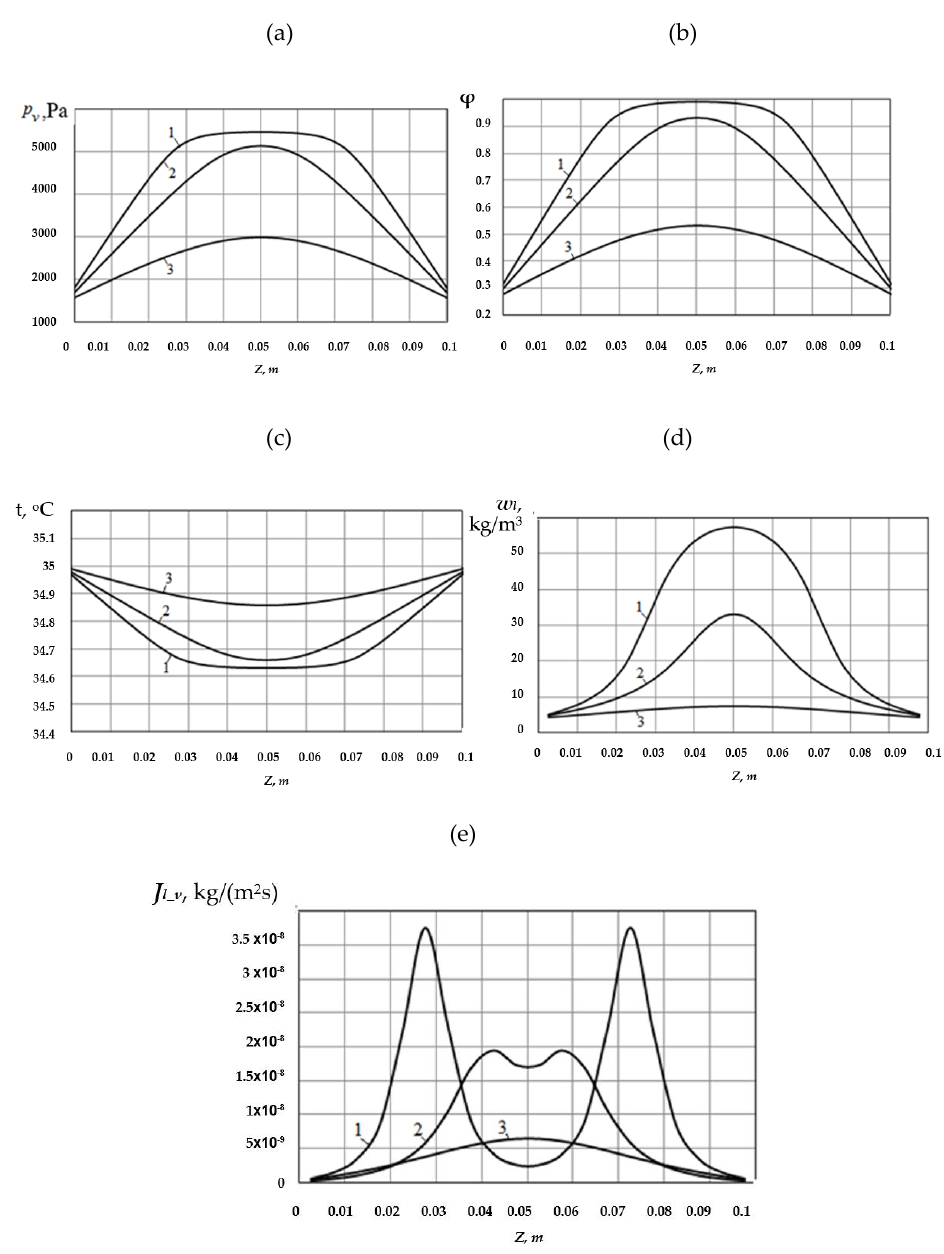
Figure 6. Distribution of the vapor partial pressure over the material thickness ( a ), relative air humidity ( b ), temperature ( c ), moisture content ( d ), and vapor flow density from the liquid column surfaces ( e ), moment of time: 1 − τ = 2.5 × 10 5 [s]; 2 − τ = 5.0 × 10 5 [s]; 3 − τ = 7.5 × 10 5